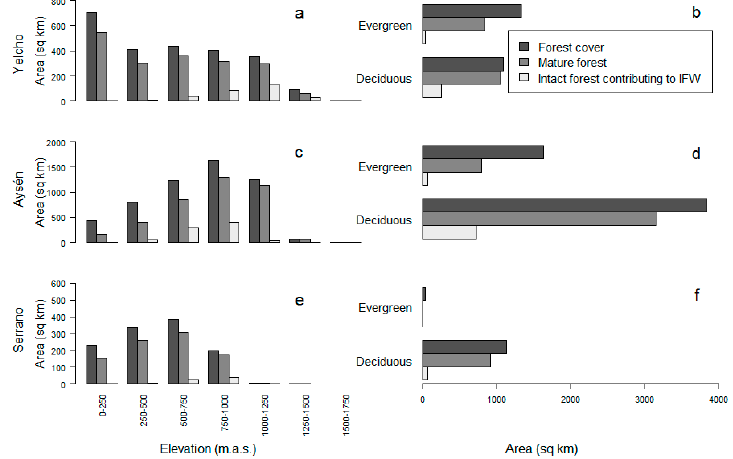
Figure 6. Comparison of total forest cover (all successional stages combined) with mature forest patches and intact forest contribution to IFWs: Yelcho river, Aysén river and Serrano river basins. Elevation distribution ( a , c , e ) and evergreen/deciduous forest type ( b , d , f ) shown respectively for the three basins. Note elevation scale adjusted for each basin.